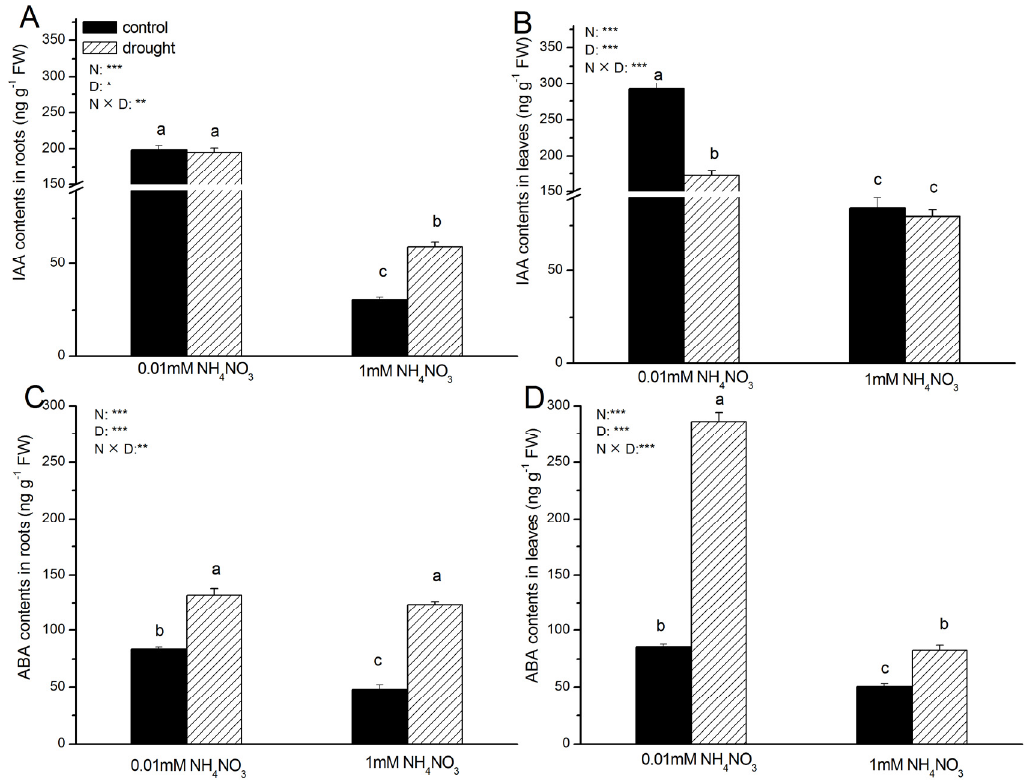
Figure 6. IAA and ABA contents in roots ( A , C ) and leaves ( B , D ) of Populus simonii as affected by nitrogen supply and drought stress. Data indicate mean ± SE ( n = 6). Different letters in the same column indicate significant differences. N, N supply; D, drought treatment; N × D, interaction of N supply and drought treatment. *, p < 0.05; **, p < 0.01; ***, p < 0.001; ns, not significant.